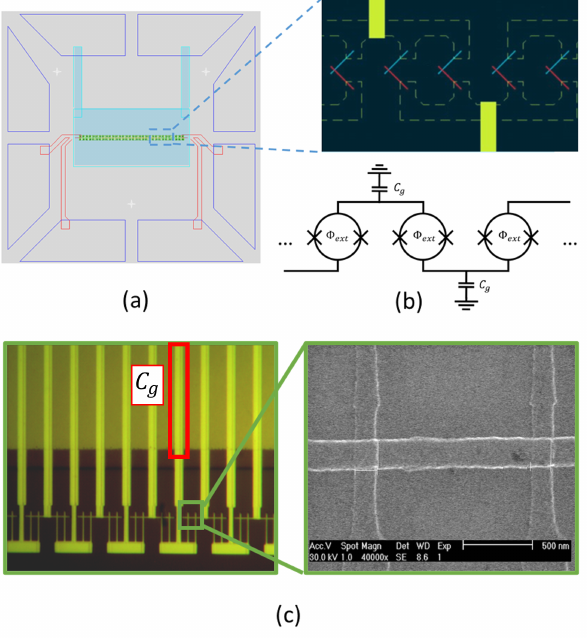
Figure 1. ( a ) Schematics of a chain of SQUIDs made of Josephson junctions with a relatively large area (i.e., large C J ) and a low transparency of the tunneling barrier (i.e., small E J ). The common ground electrode made of a sputtered Pt film is shown in pale blue. A few nm thick AlO X oxide covers this electrode and serves as a pinhole-free dielectric that isolates the ground from the SQUIDs. The typical value of the capacitance that shunts a single SQUID, C g , is 0.5 nF for 50 µ m 2 pad area. ( 2 e ) 2 = 8 mK. ( b ) The circuit diagram of a This C g corresponds to a charging energy per SQUID E C = 2 C g chain of SQUIDs. ( c ) An alternative design of a chain of SQUIDs shunted by external capacitors to the ground. The vertical 5 µ m-wide pads are the ground electrodes for the capacitors, a few nm thick AlO X serves as a dielectric between the electrodes.